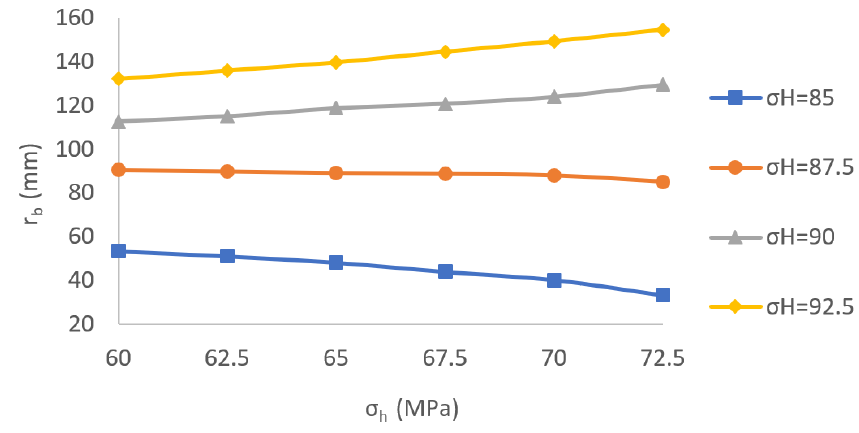
Figure 6. Breakout depth for different in situ stresses.